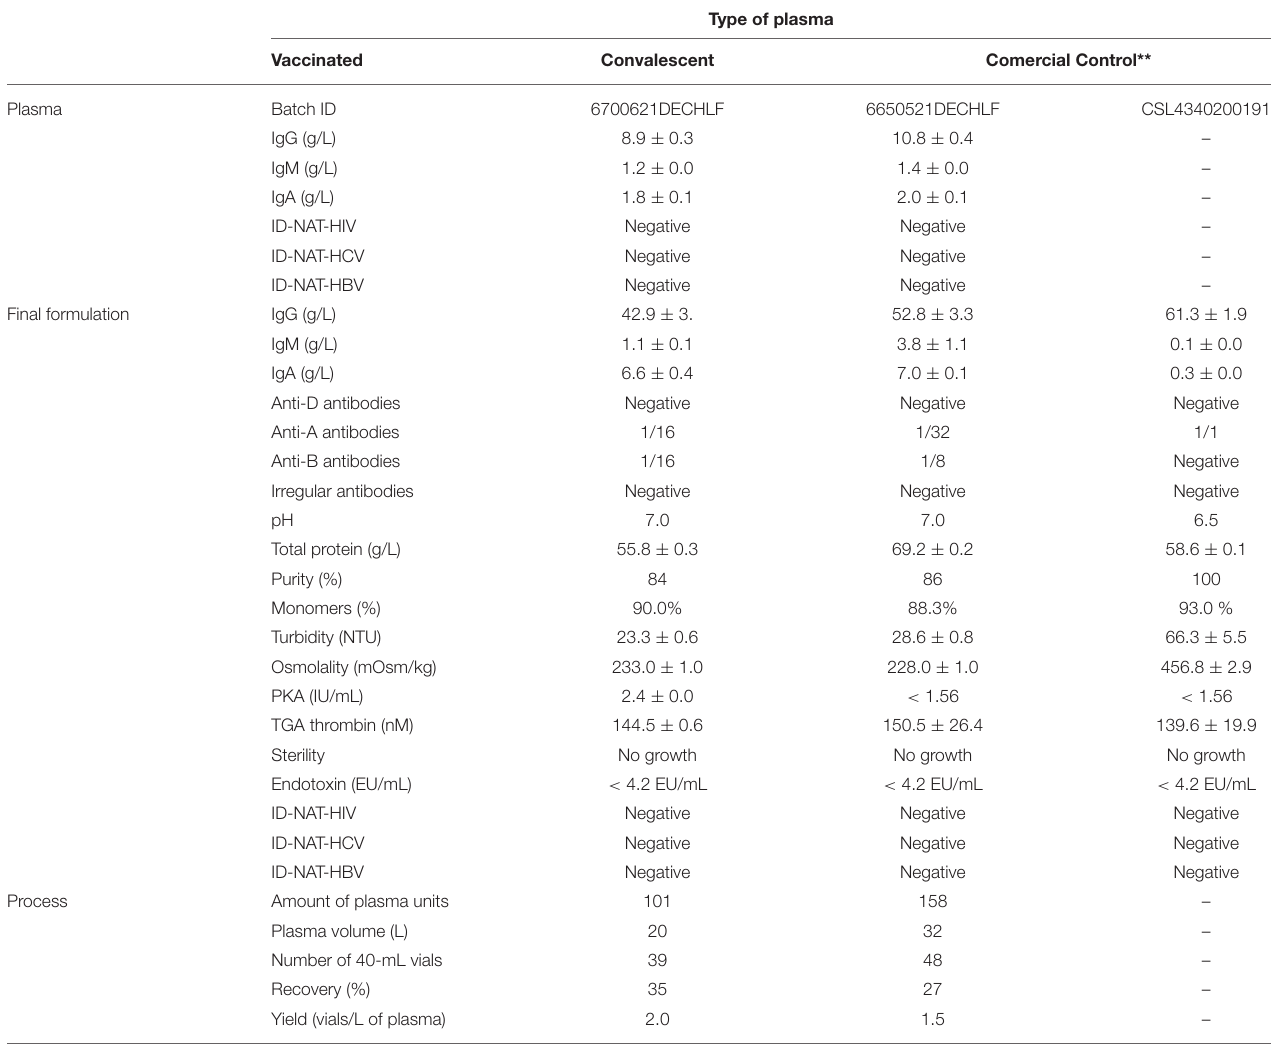
* Results are presented as the average ± SD of a triplicate of determinations. ** The commercial control is used as reference.